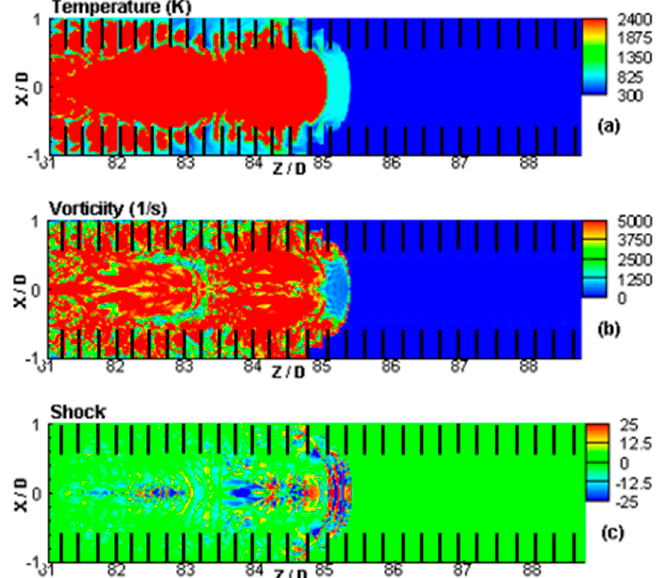
Figure 5. The characteristic instantaneous snapshots of the temperature ( a ), vorticity ( b ) and shock waves ( c ) taken at the saturation phase of the evolution of a flame with the thermal expansion ratio Θ = 8 propagating in a channel with the blockage ratio α = 1/2.